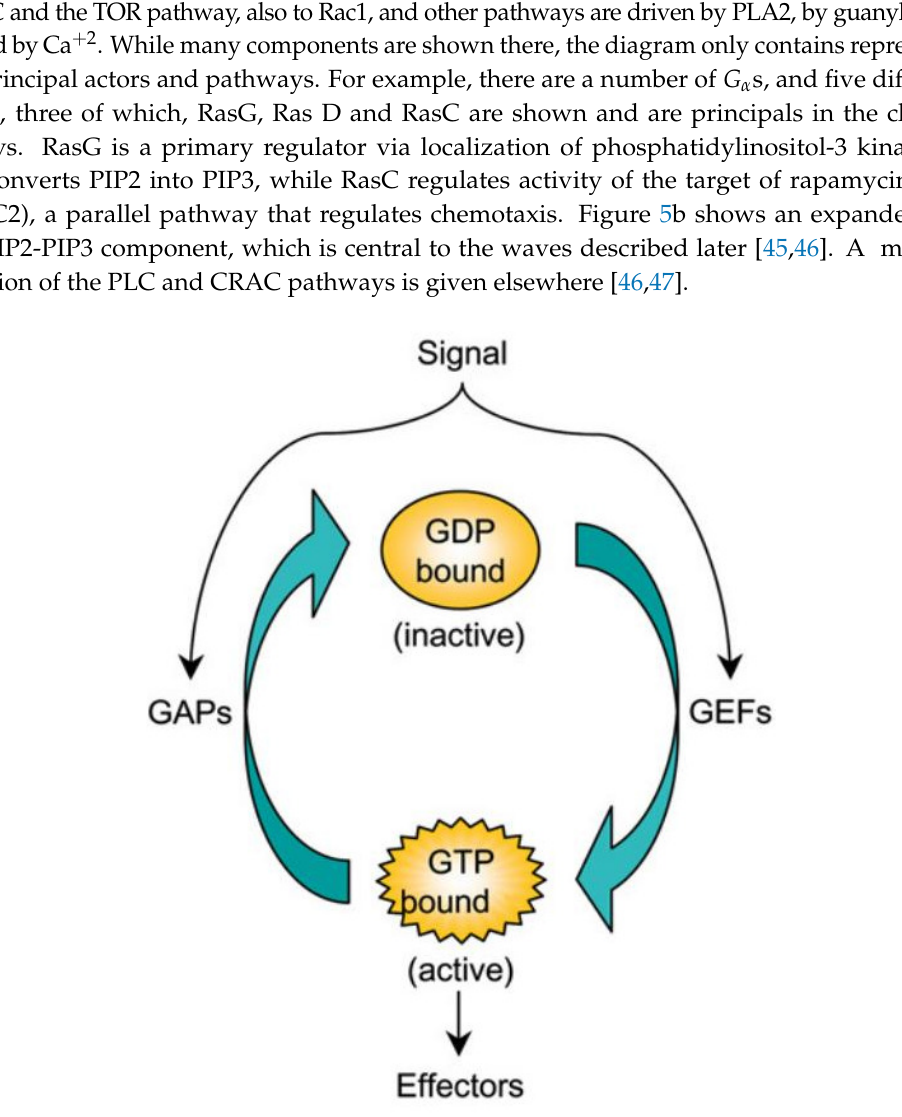
Figure 4. The molecular switch for a RHo GTPase—Rho is ‘on’ or active when GTP-bound, and ‘off’ or inactive when GDP-bound. From Charest et al.